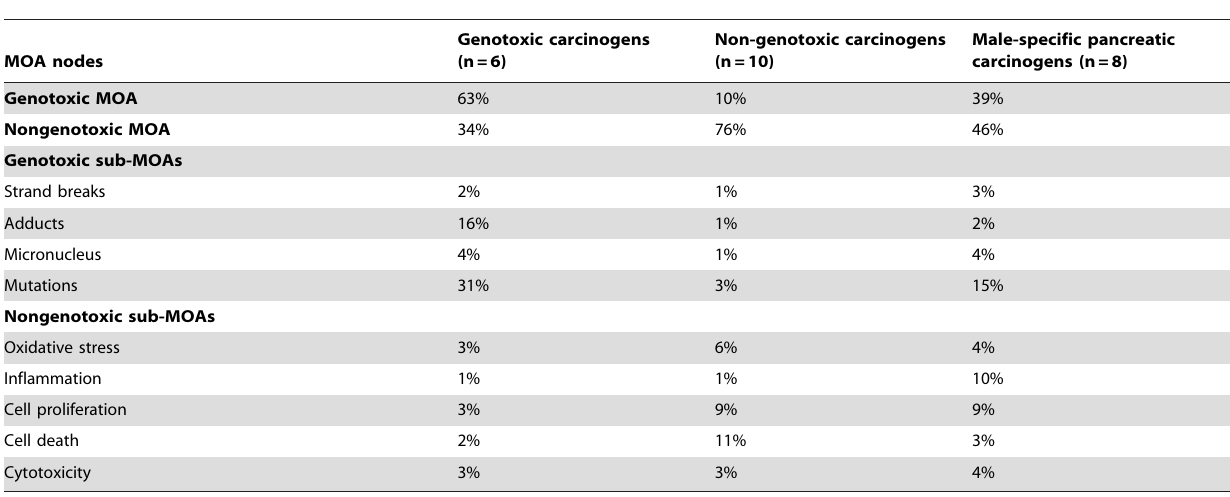
Table 3. Automatic classification of PubMed abstracts for genotoxic, non-genotoxic and male-specific pancreatic carcinogens.